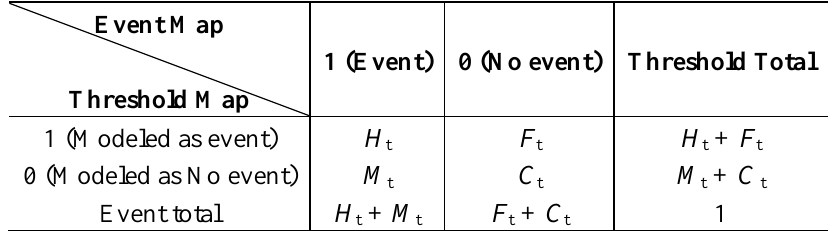
Table 1. Contingency table used to compute a threshold point on the ROC curve. H M , and C are respectively the proportion of grid cells corresponding to hits, false alarms, t t misses and correct rejections (Modified from Pontius and Parmentier